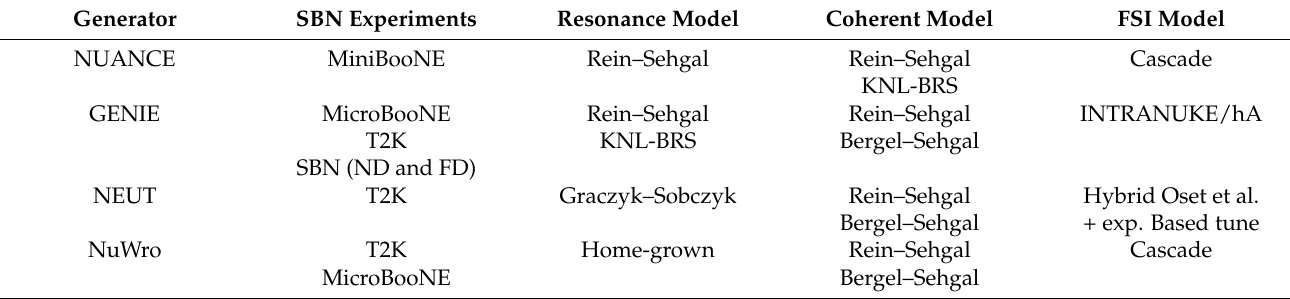
Table 20. Each generator has a different approach to the transition region between RES and DIS. Furthermore, the same model can be implemented differently in different generators. KNL-BRS: Kuzmin–Naumov–Lubushkin–Berger–Sehgal with axial form factor fit to MiniBooNE data. Graczyk–Sobczyk: relation between form factors and helicity